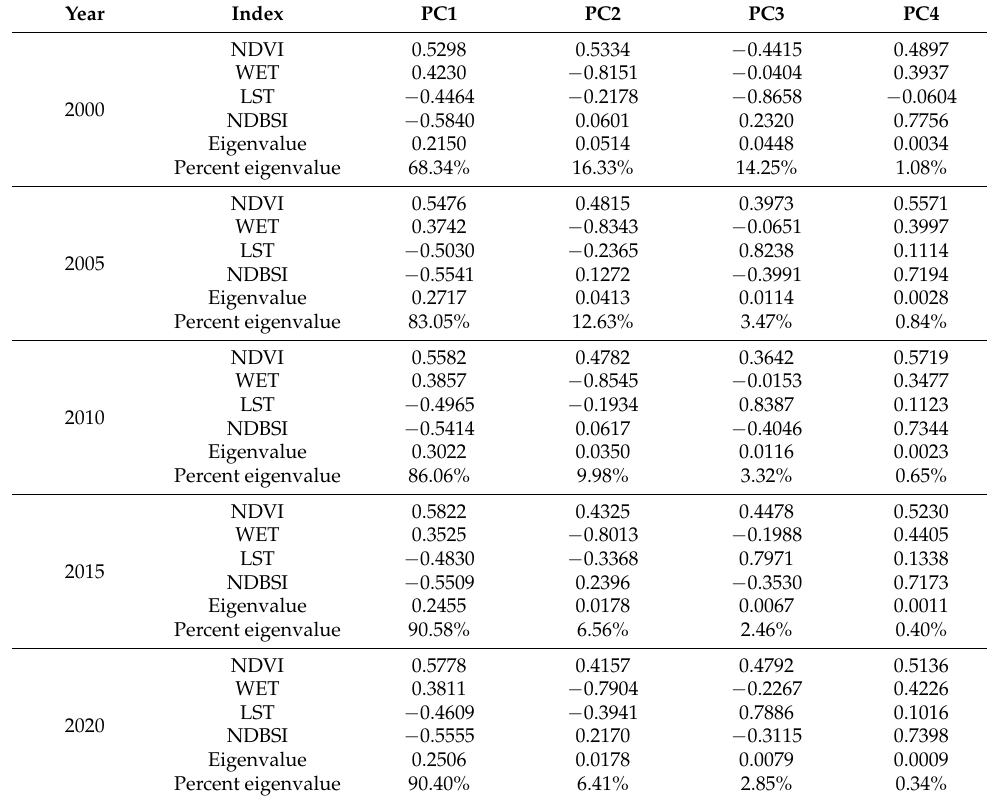
Table 3. Results of RSEI principal component